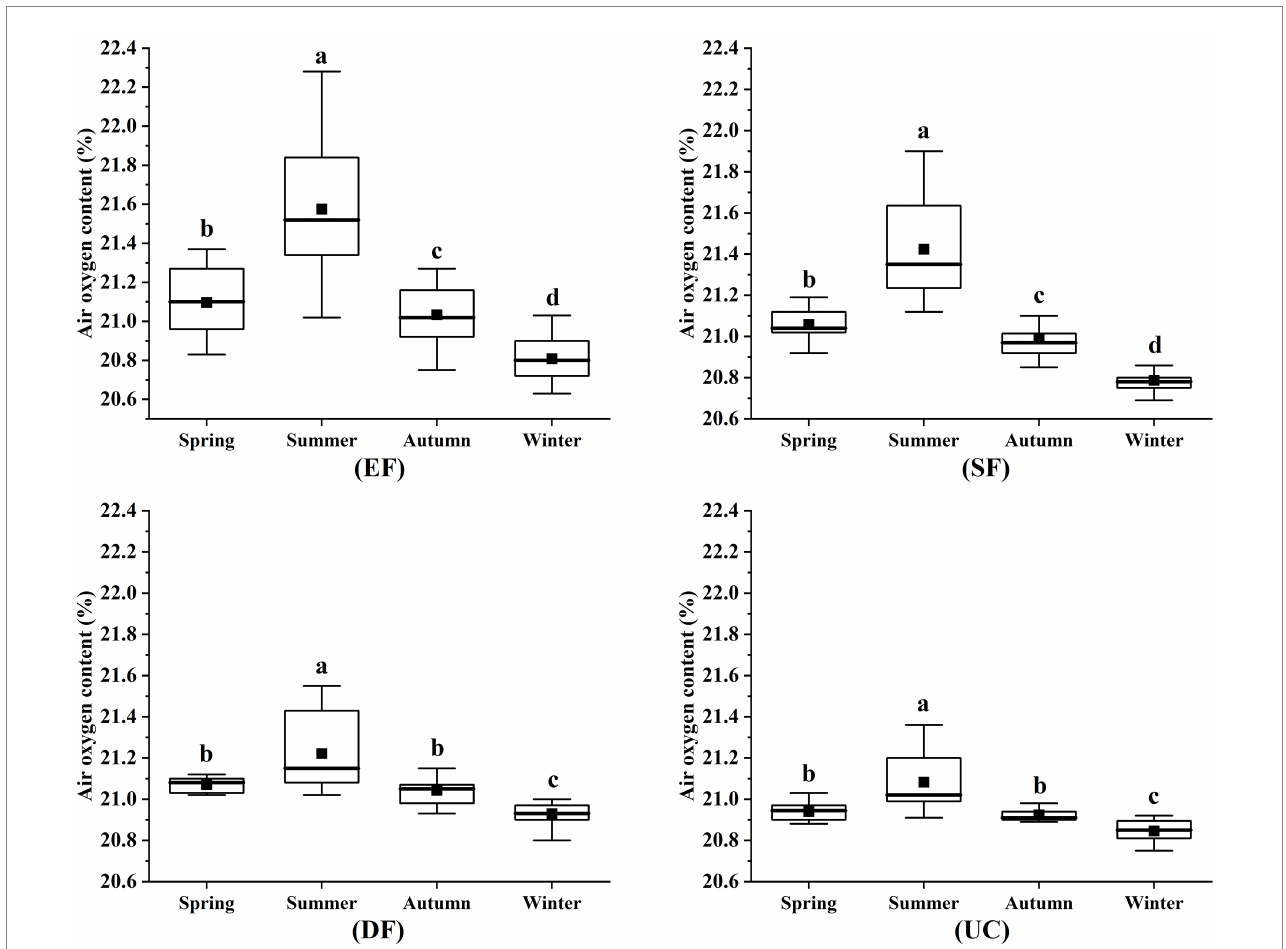
FIGURE 6 Seasonal variations of AOC of urban forests in different geographical